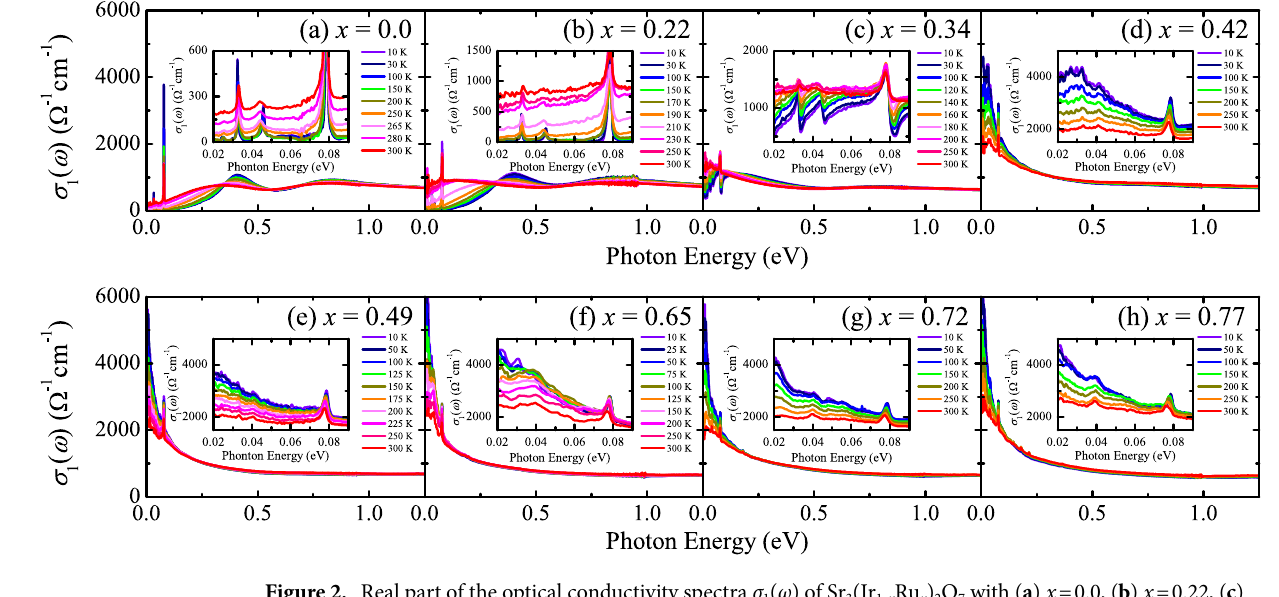
Figure 2. Real part of the optical conductivity spectra σ 1 ( ω ) of Sr 3 (Ir 1- x Ru x ) 2 O 7 with ( a ) x = 0.0, ( b ) x = 0.22, ( c ) x = 0.34, ( d ) x = 0.42, ( e ) x = 0.49, ( f ) x = 0.65, ( g ) x = 0.72, and ( h ) x = 0.77 at selected temperatures. Insets show σ 1 ( ω ) in the energy region below 0.1 eV.